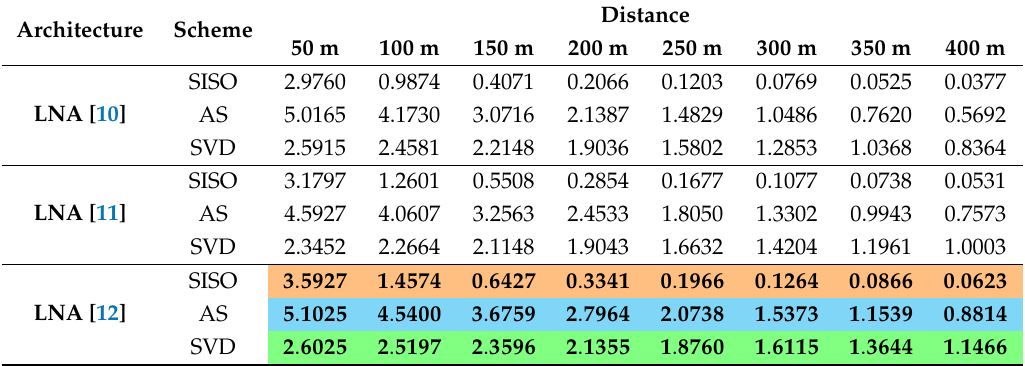
Table 3. Energy efficiency , in bit/J/Hz, as a function of the distance for the different LNA architectures and transmission schemes, with N t = N r = 2.